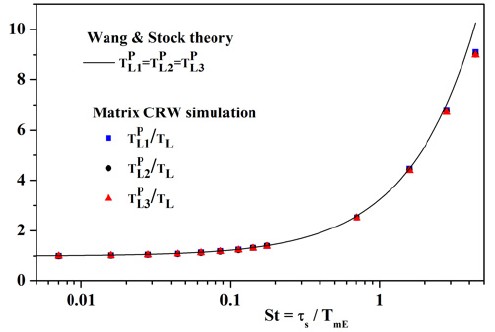
Figure 20. Particle Lagrangian time scale (g = 0).